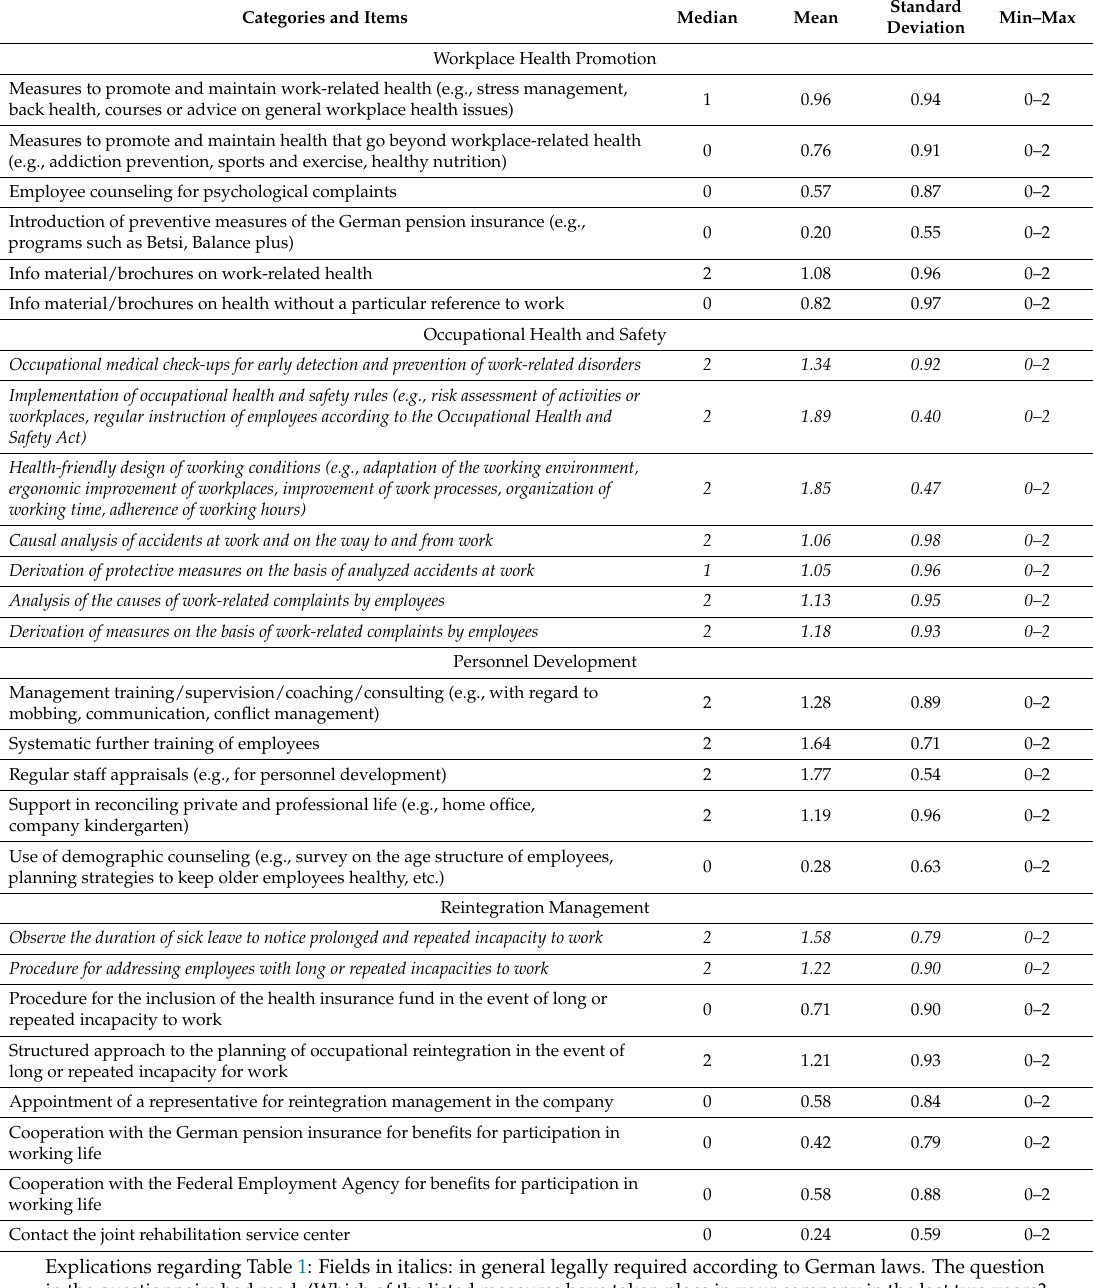
Standard Min–Max Deviation